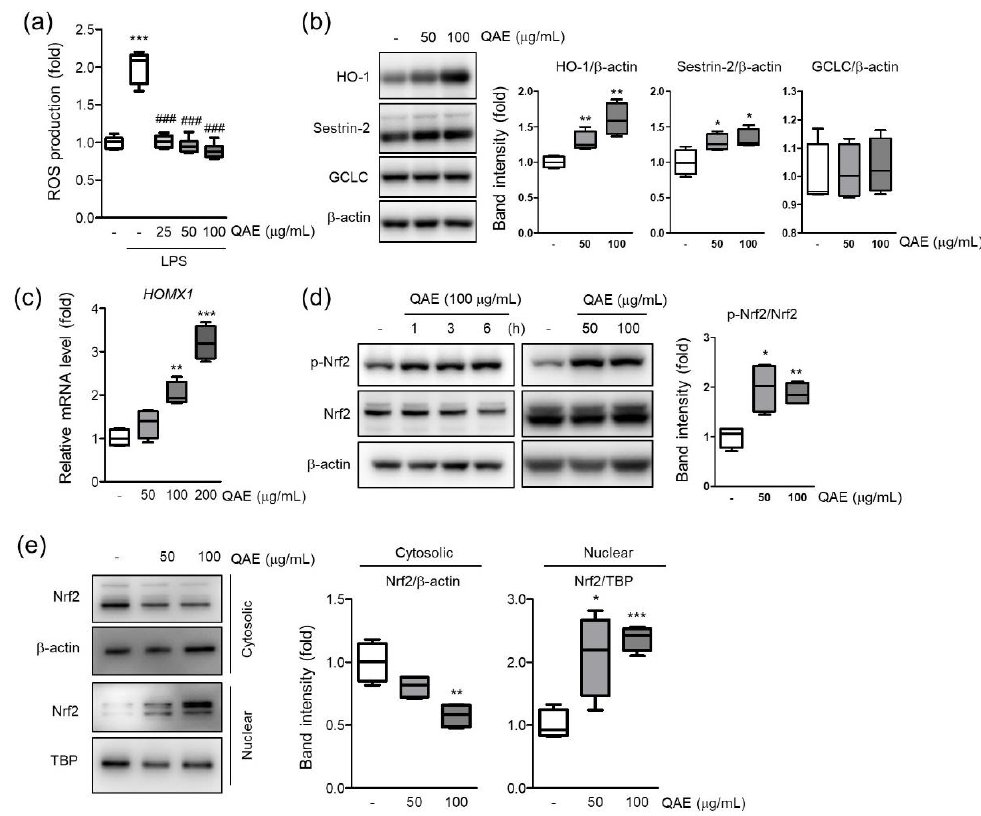
Figure 6. QAE activates the nuclear factor erythroid-2-related factor 2 (Nrf2)/heme oxygenase-1 (HO-1) signaling pathway in BV2 microglial cells. ( a ) H 2 O 2 production. Cells were pretreated with QAE (25–100 µ g/mL, 3 h), and further exposed to LPS (100 ng/mL, 12 h). After staining with H 2 DCF-DA (10 µ M, 0.5 h), dichlorofluorescein (DCF) fluorescence intensity was detected using an automated plate reader ( n = 8). ( b ) Expression of antioxidant protein. Cells were treated with QAE (50, 100 µ g/mL) for 8 h. Equal loading of each protein was verified by β -actin immunoblotting ( n = 4). ( c ) Heme oxygenase-1 (HO-1) ( HOMX1 ) mRNA level. Cells were treated with QAE (50–200 µ g/mL) for 7 h. Relative mRNA expression of HO-1 was normalized by expression of GAPDH ( n = 4). ( d ) Phosphorylation of Nrf2. Cells were treated with 100 µ g/mL of QAE for the indicated time (left), or 50, 100 µ g/mL of QAE for 3 h (right) ( n = 4). ( e ) Expression of Nrf2 in the cytoplasm and nuclear. Expressions of Nrf2 were normalized by β -actin (cytosolic) or TBP (nuclear) immunoblotting ( n = 4). Significant versus control, * p < 0.05, ** p < 0.01, *** p < 0.001; Significant versus LPS alone-treated group, ### p <